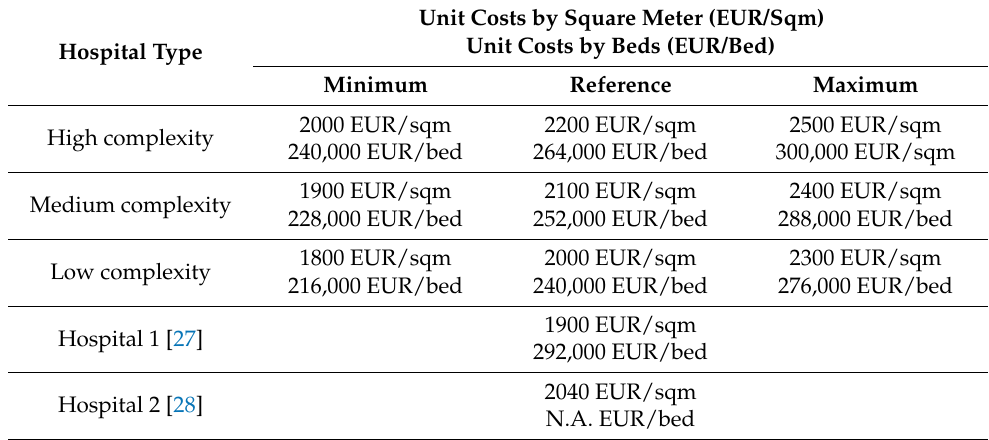
Table 2. Hospital construction cost in EUR/square meter according to gray literature.